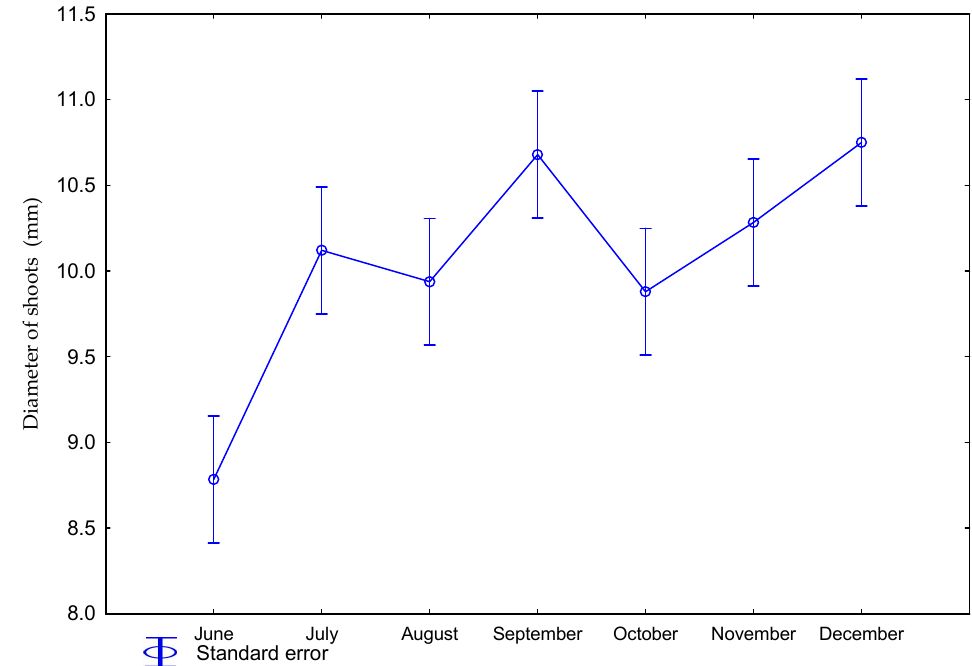
Figure 3. Diameter of shoots during the vegetation period in the years 2014–2016 (average for years).